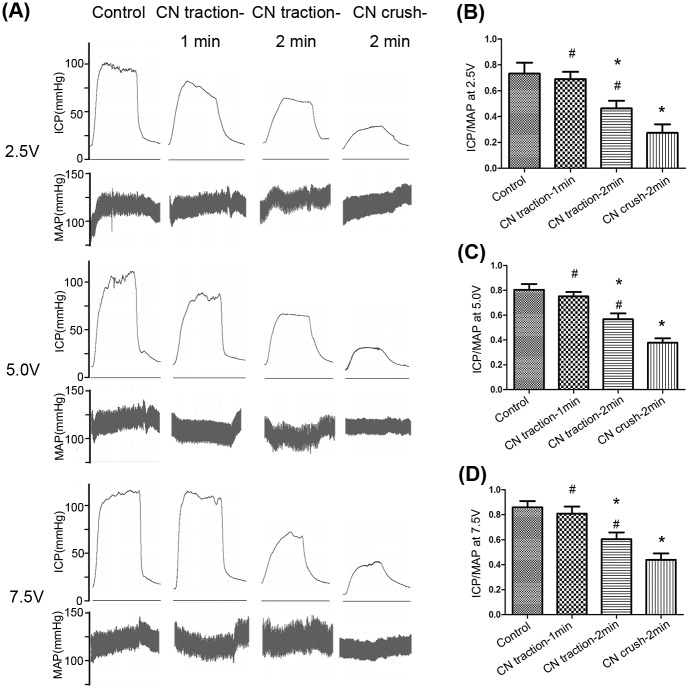
Comparison of erectile function in each group.(A) Representative recordings of intracavernosal pressure (ICP) and arterial pressure during 1-min electrical stimulation at 2.5V, 5.0V and 7.5V. (B,C,D) The ratio of ICP to mean arterial pressure (MAP) for each group, at 2.5V, 5.0V and 7.5V. N = 8 in each group. * P<0.05 compared with control group. # P<0.05 compared with 2-min CN crush group.